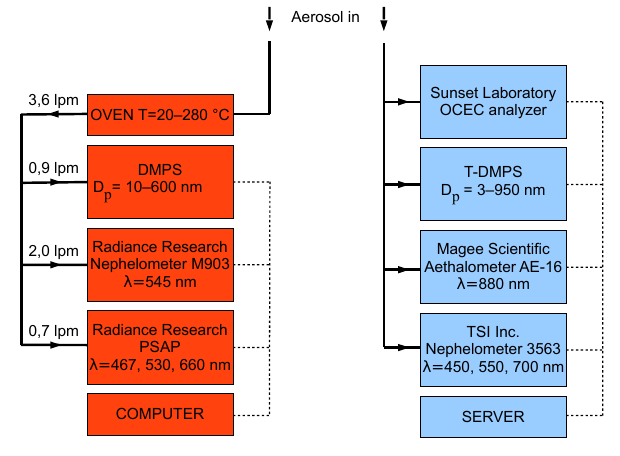
Fig. 1. The system setup used during the short field campaign at the SMEAR III